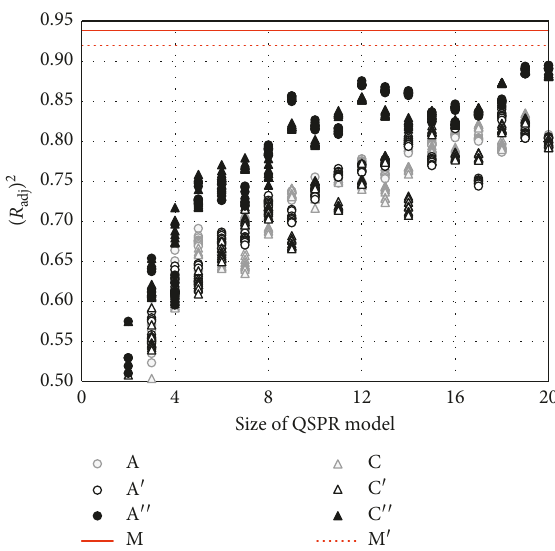
2 values characterizing a variety of Figure 7: Distributions of R adj ) ( QSPR models predicting d parameter based on PaDEL descriptors or factors resulting from MARSplines models. Open grey symbols represent models built using unnormalized parameters orthogo- nalized in two ways. Open black symbols stand for similar models but with normalized data. Filled black symbols denote QSPR models obtained by augmenting descriptors pool with orthogonal MARSplines factors. Red line documents the quality of the model obtained using all factors identified in the MARSplines procedure (Eq. (4)).